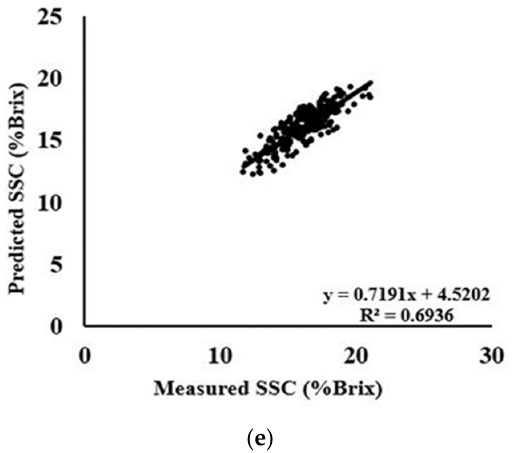
Figure 7. Scatter plots of measured versus predicted SSC using SVM-R method with Autoscale